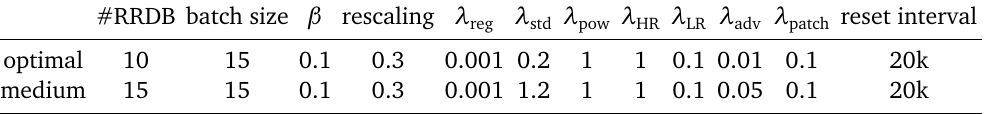
Table 1: Sets of hyperparameters used for networks described in Fig. 2. Two sets are presented, one which optimized performance, and a second which which performed slightly worse. β is the residual scale